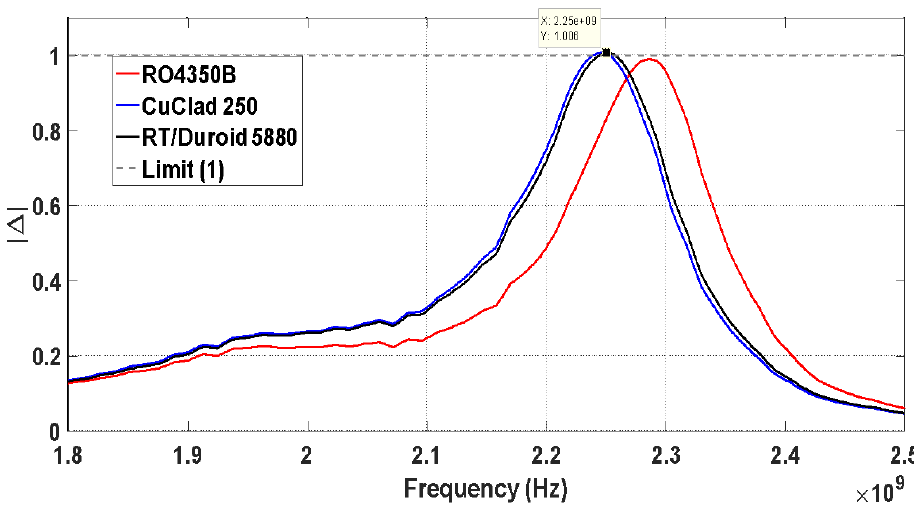
Figure 10. Stability measure (| Δ |) simulation for the selected RF substrates at 2.25 GHz.